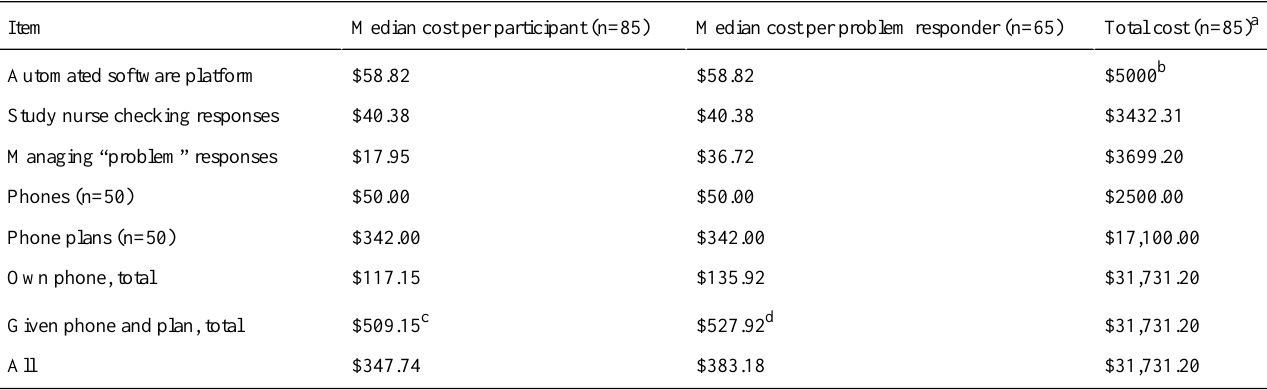
Table 3. Deconstructed costs of WelTel OakTree Study during intervention year (in Canadian